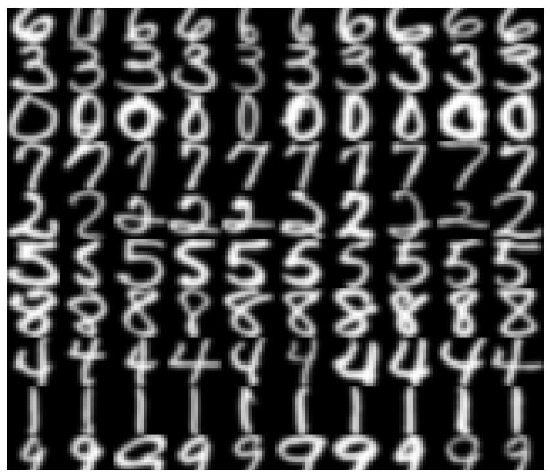
Figure 3. Typical examples of USPS dataset.